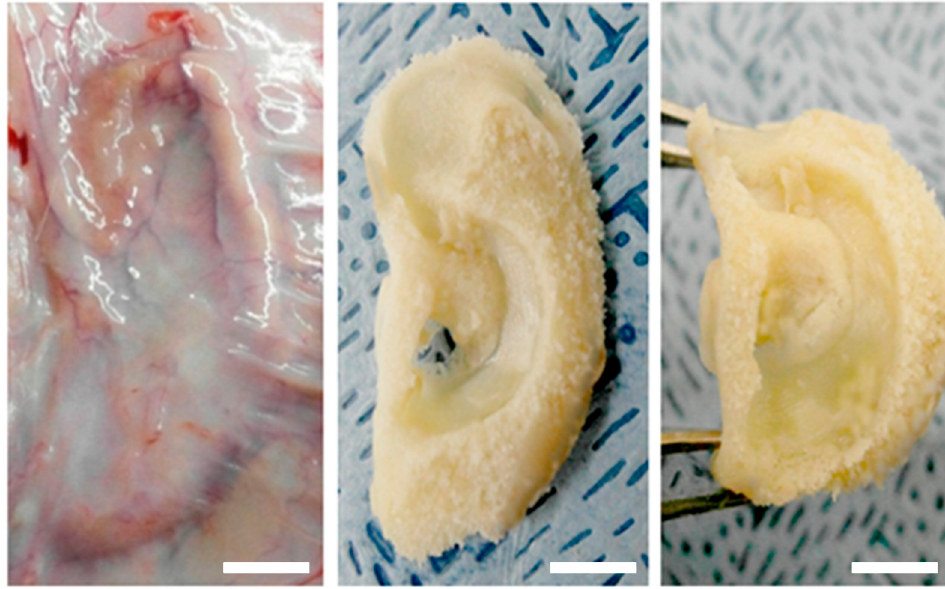
Figure 7. Engineered ear-shaped cartilage: Surgical view of 6 weeks after implanting, after harvesting, and after subjecting to physical stress. Scale bars = 1 cm.